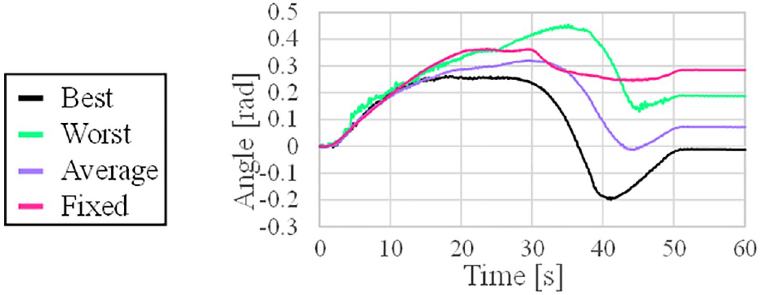
Fig 11. Maximum value among manipulator joints over time.